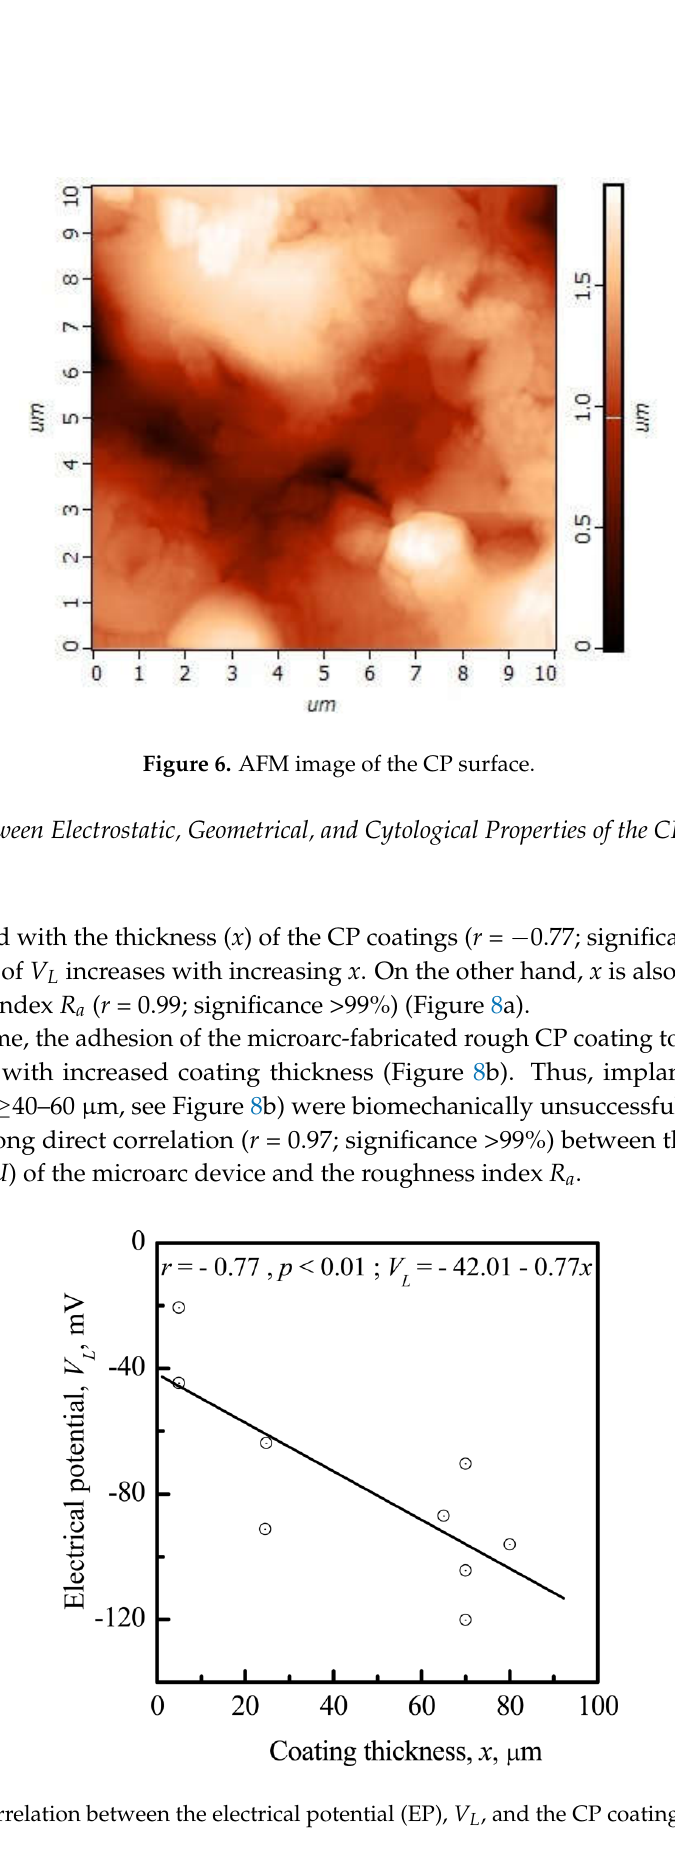
Figure 7. Correlation between the electrical potential (EP), V L , and the CP coating thickness, x.